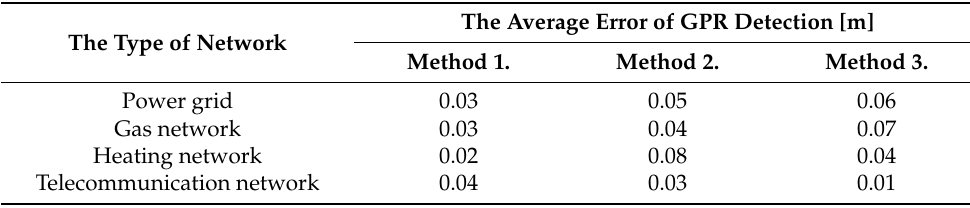
Table 3. Standard errors of georadar detection obtained for three measurement